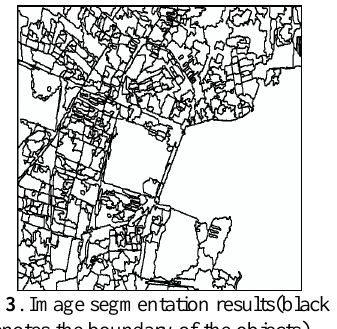
Figure 3 . Image segmentation results(black lines denotes the boundary of the objects).